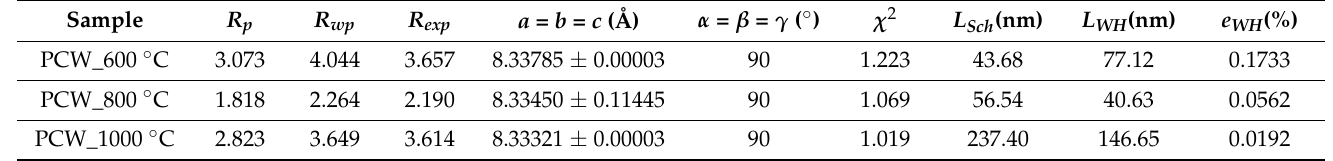
Table 1. Parameters of the Rietveld refinement, using Scherrer and Williamson–Hall methods. Sample R